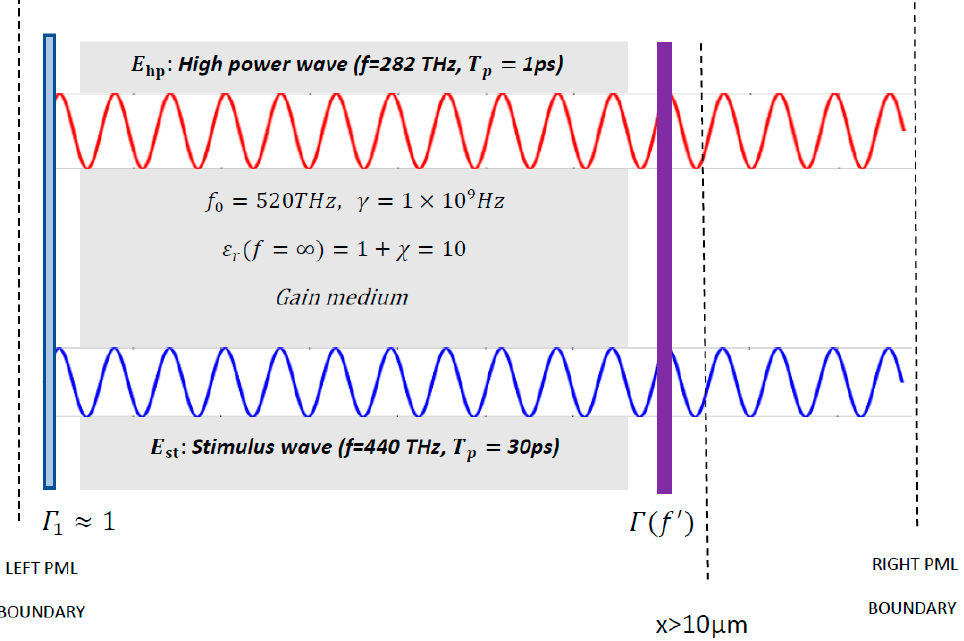
Figure 13. The configuration for computing the gain spectrum of the stimulus wave for 𝑓 0 = 520 THz . Our problem: For the gain maximizing resonance frequency of f (cid:2868) = 520 THz, find the maximum stimulus wave amplitude (gain factor) (cid:3627)𝐸 (cid:3046)(cid:3047),(cid:3040)(cid:3028)(cid:3051) (cid:3627) in the cavity for each stimulus wave frequency